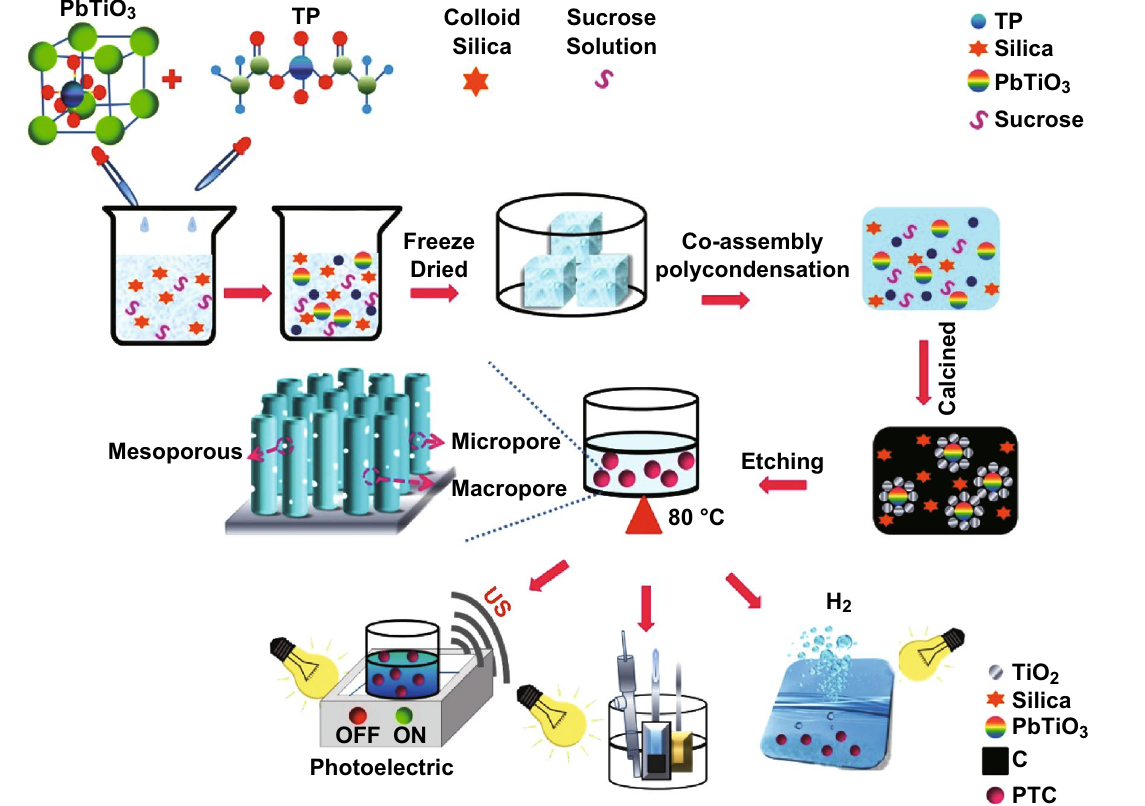
Fig. 1e. The deformation and vibration of –OH caused by intermolecular H bonds mainly appear at 3420 and 927 cm −1 [43], and the peak at 1706 cm −1 corresponds to the vibration of carbonyl and carboxyl groups (ν–C=O) [44]. Peaks at 1556 and 1445 cm −1 are related to asymmetric ( as ) and sym- metric ( s ) stretching, indicating coordination bond formation in TiO [20]. One significant change in the FT-IR curves of 2 unannealed PTC precursor after etching is the absence of peaks at 1122 and 766 cm −1 , which are indexed to stretching vibration Si–O—originating from the SiO template. This 2 result proves that SiO is completely eliminated by NaOH 2 etching